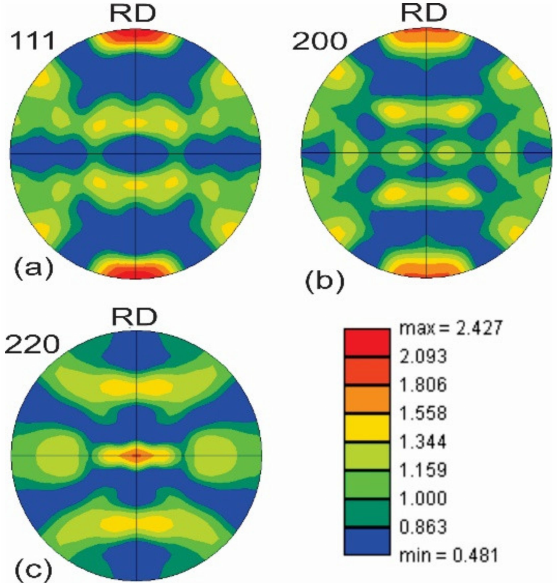
Figure 15. ( a ) { 111 } , ( b ) { 100 } , and ( c ) { 110 } PFs of the tubes drawn with the standard die after the second drawing step at min position. The maximum intensity of PFs is approximately 2.42.